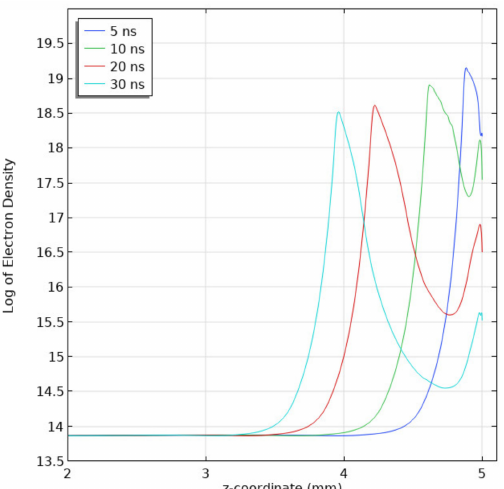
Figure 19. Line diagram along the symmetry axis of the log of the Electron Density profile for an applied voltage of 2 kV at pressure 10 kPa. Scaling parameter for density profiles: 20 on logarithmic plot represents a density value of 10 20 m − 3